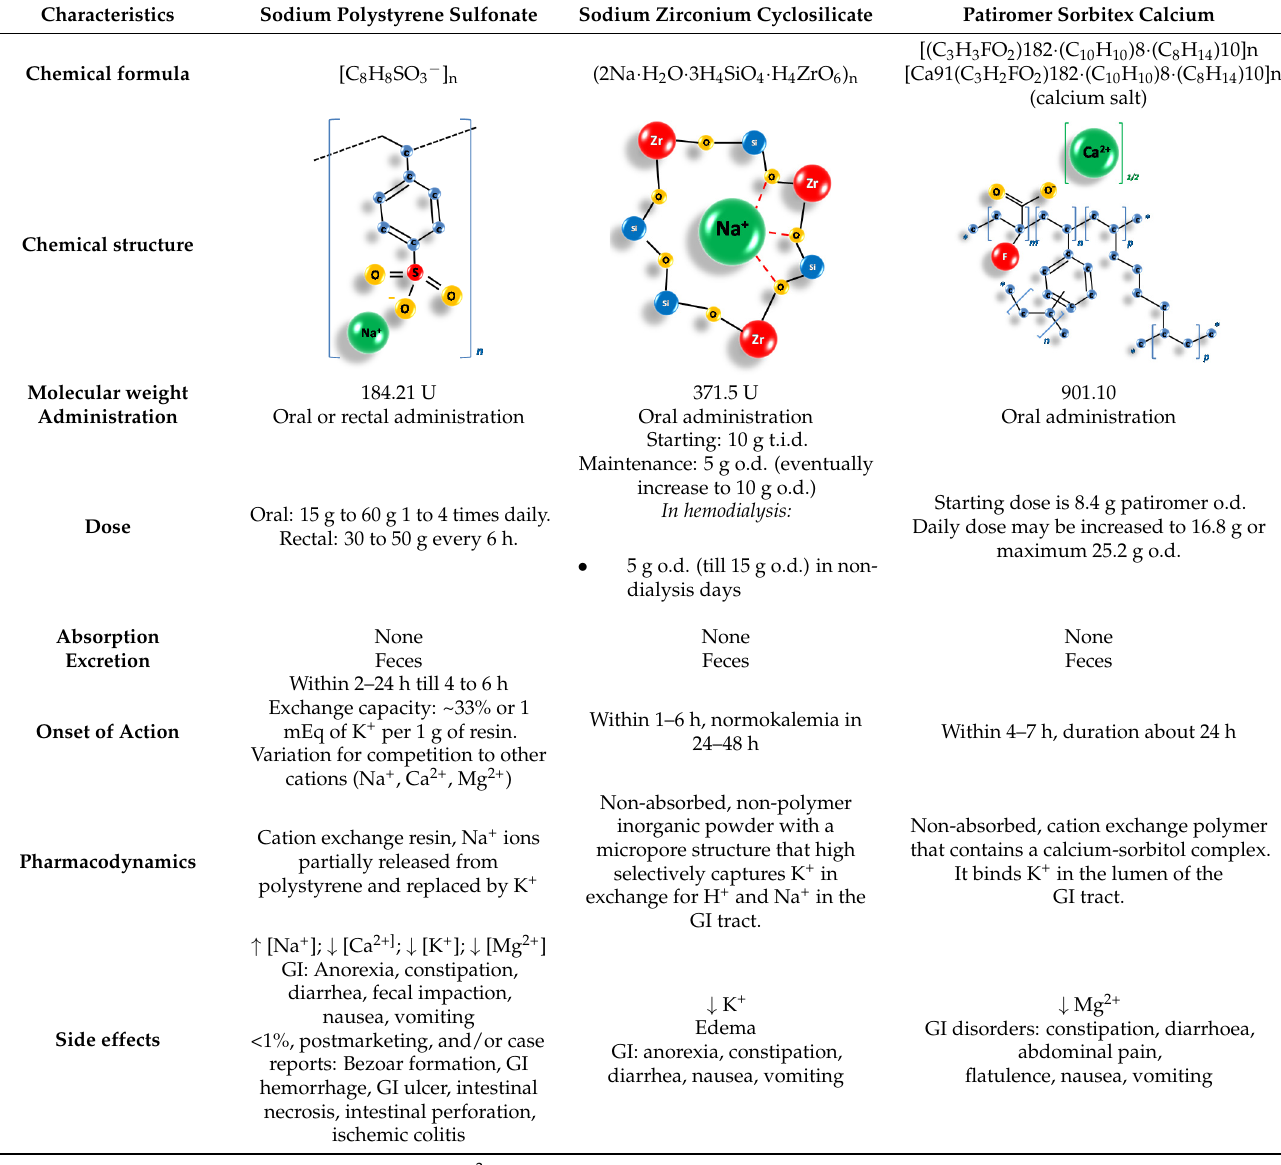
Table 1. Main characteristics of potassium binders: Sodium polystyrene sulfonate, sodium zirconium cyclosilicate, and patiromer sorbitex calcium.